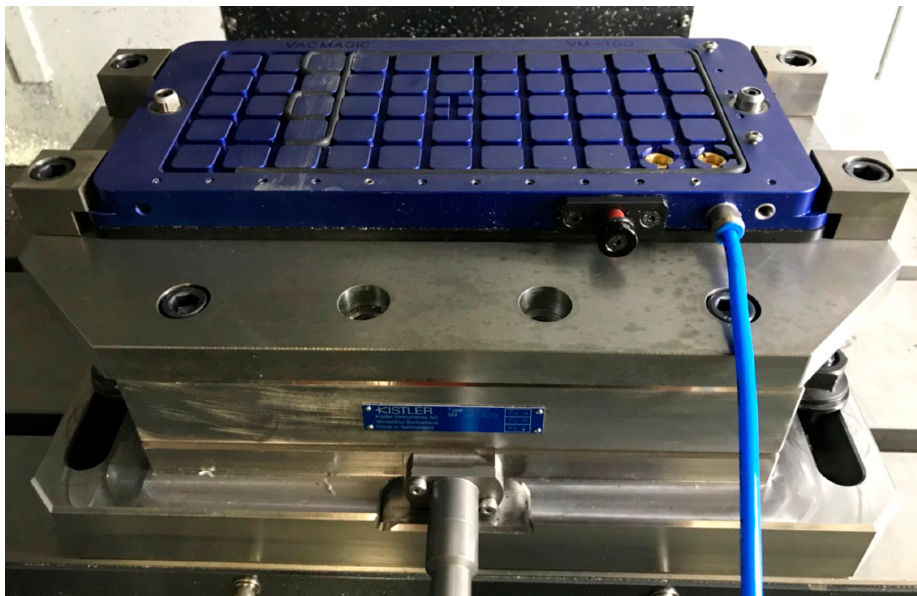
Figure 3. The overall setup of the adapter tray fixture.